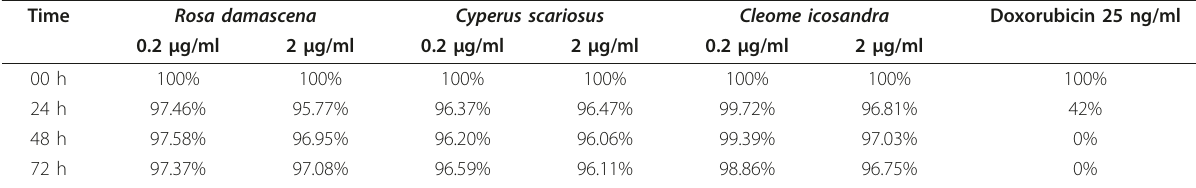
Table 4 Cytotoxic activity of three plants at two different concentrations